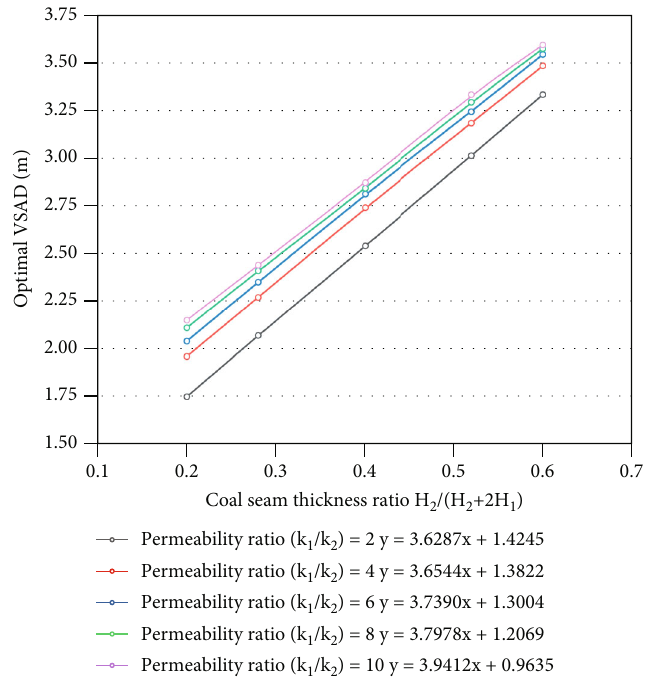
/ ð H + 2 H Þ ) for di ff erent coal seam permeability ratios 2 2 1